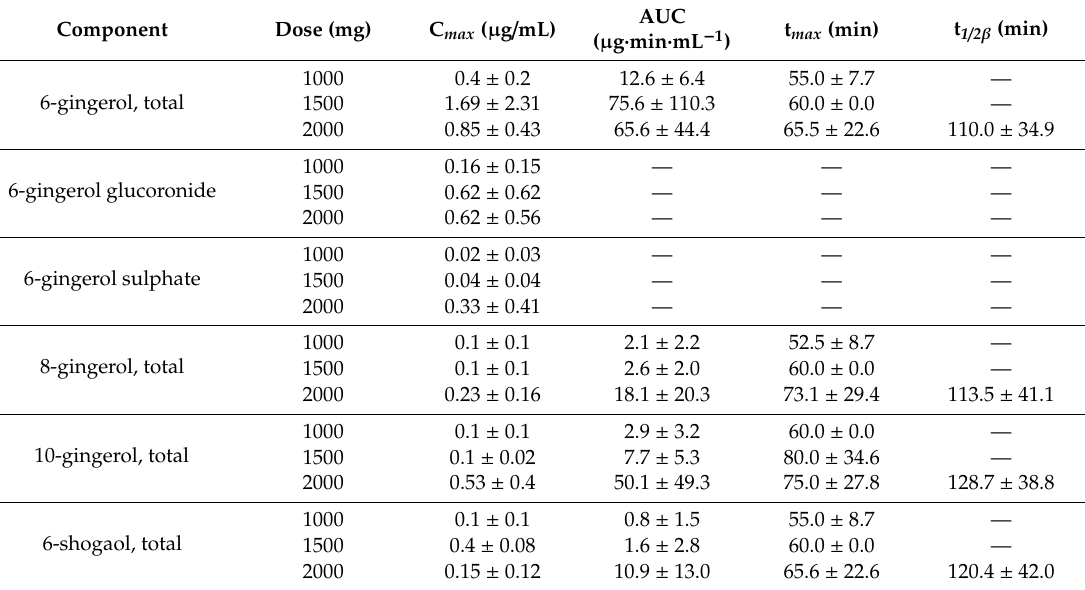
Table 1. Pharmacokinetic parameters for the main active components of